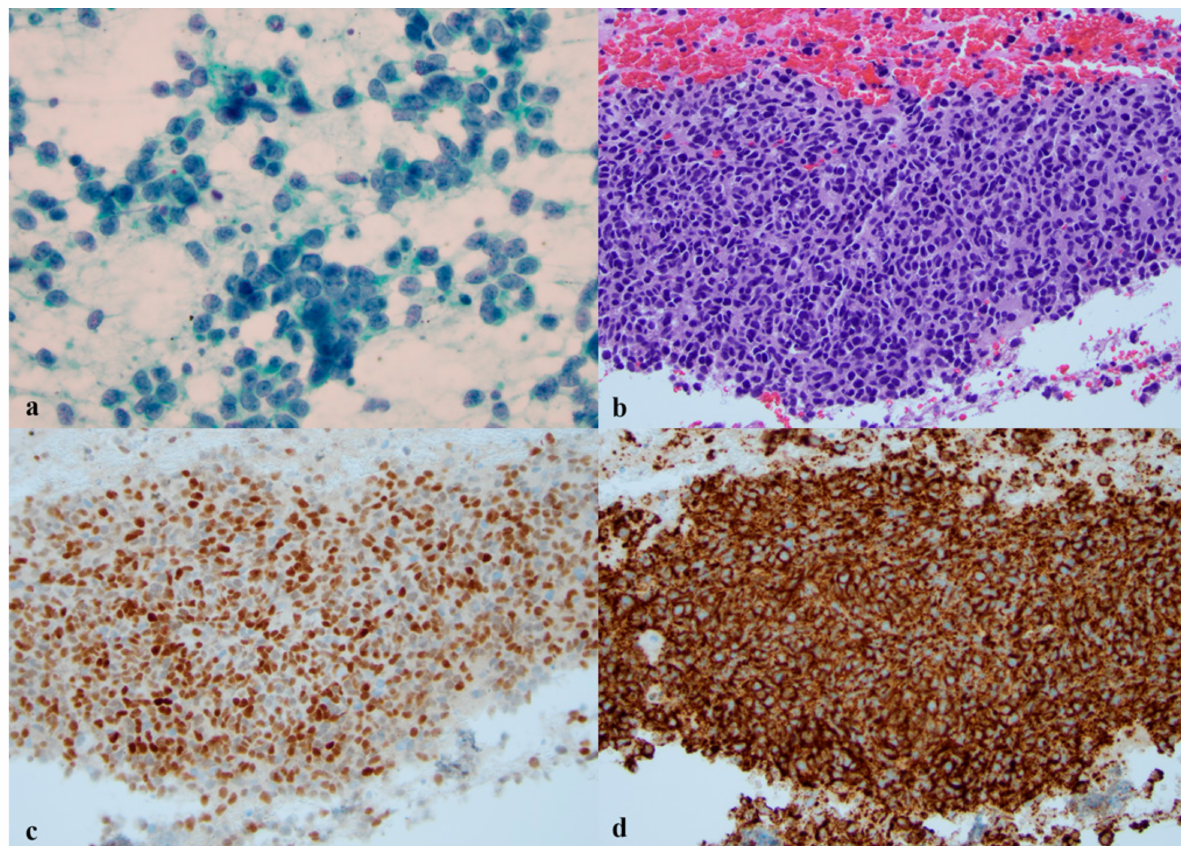
Figure 1. Lung small cell carcinoma. ( a ) A smear shows clusters of loosely cohesive of relatively uniform small cells with high nuclear to cytoplasmic ratio. The chromatin is powdery and the cytoplasm is scant. There is focal nuclear molding and necrosis is seen in the background ( × 400, Papanicolaou stain). ( b ) A cell block shows a tissue fragment of malignant cells ( × 200, H and E stain). ( c ) INSM1 highlights neuroendocrine tumor cells, nuclear staining on cell block ( × 200, IHC). ( d ) CD56 is positive in neuroendocrine tumor cells, cytoplasmic membrane staining on cell block ( × 200,